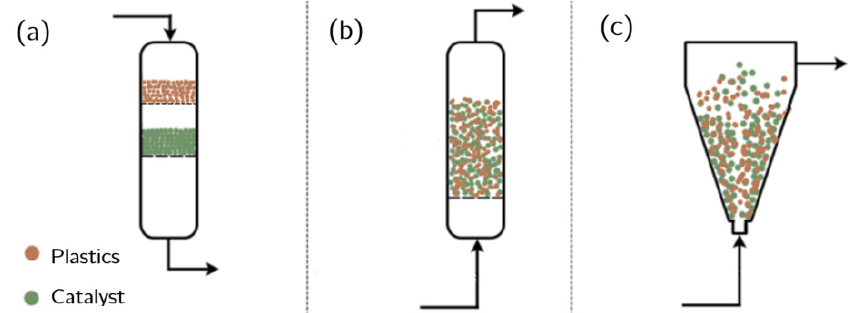
Figure 6. Different possible continuous reactor configurations for catalytic pyrolysis of plastic waste: ( a ) fixed bed reactor, ( b ) fluidized bed reactor, ( c ) conical spouted bed reactor. Adapted from scheme of Ochoa et al. [17].